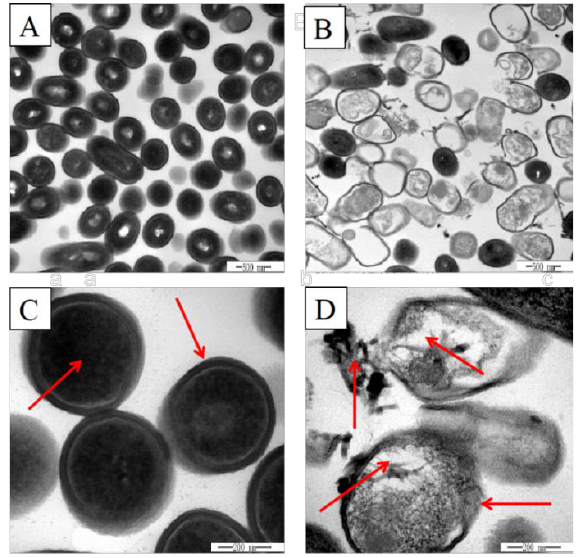
Figure 2. Effects of plantaricin Q7 on the morphology and internal structure of L. monocytogenes . ( A , C ) Control group, ( B , D ) treatment group, ( A , B ) 40,000× magnification, ( C , D ) 150,000× magnification. The red arrows in Figure 2C,D pointed to the cell wall and cell content of the bacteria in the control group and the treatment group respectively.